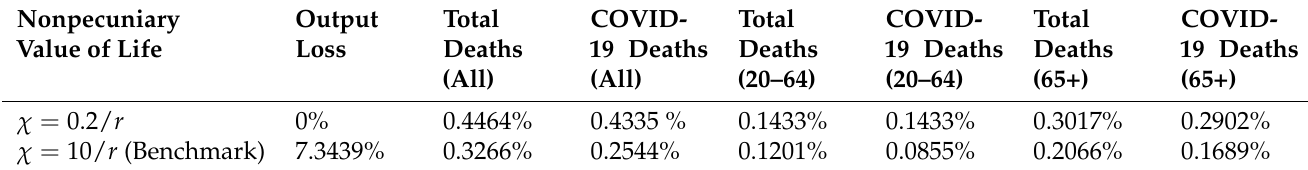
Table 3. A comparison of mortality rates for different nonpecuniary values of life; death rates from Table 1.